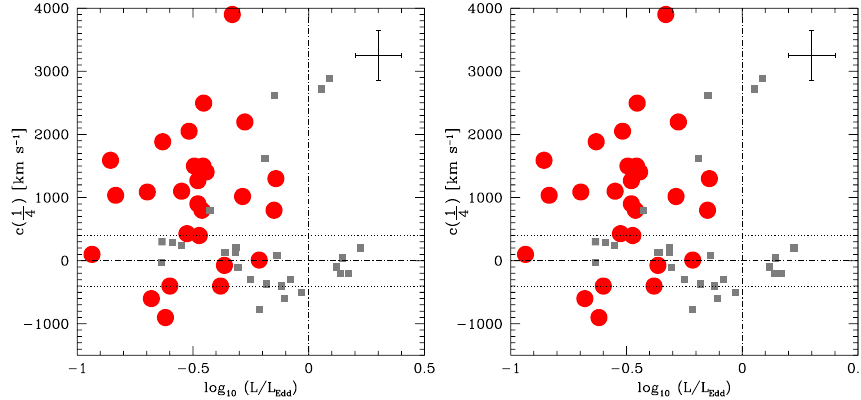
) of H (cid:12) vs. the Eddington ratio (left) 4